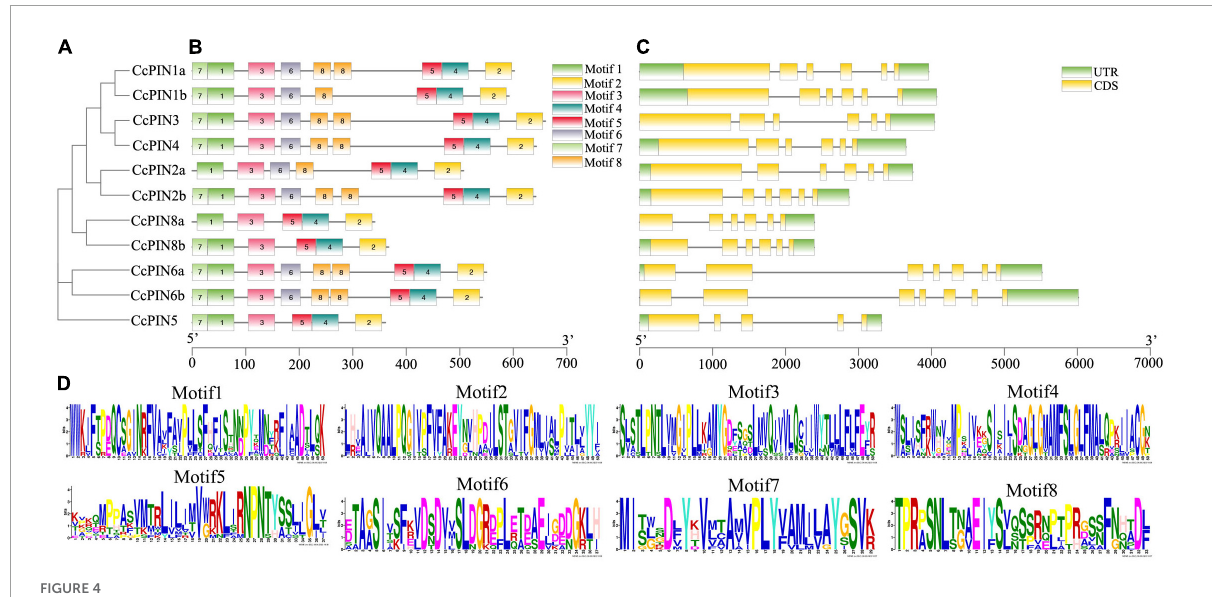
FIGURE4 Motif and gene structure analysis of CcPINs. (A) Phylogenetic relationships. (B) Motif distribution. (C) Exon-intron structures. (D) Motif